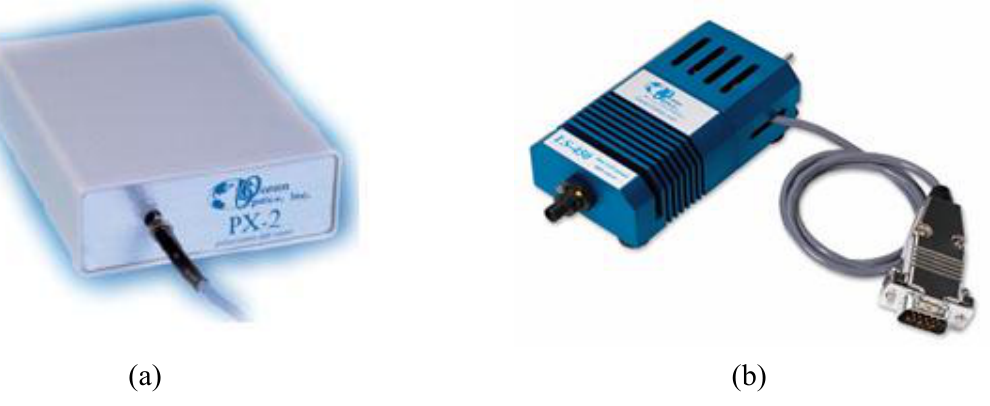
Figure 4 . Two excitation light sources were considered for the real-time PCR on-chip system: (a) shows the white light lamp with light-intensity control ability to 3% variation, and (b) shows the LED providing a simple excitation light source with high intensity variation to